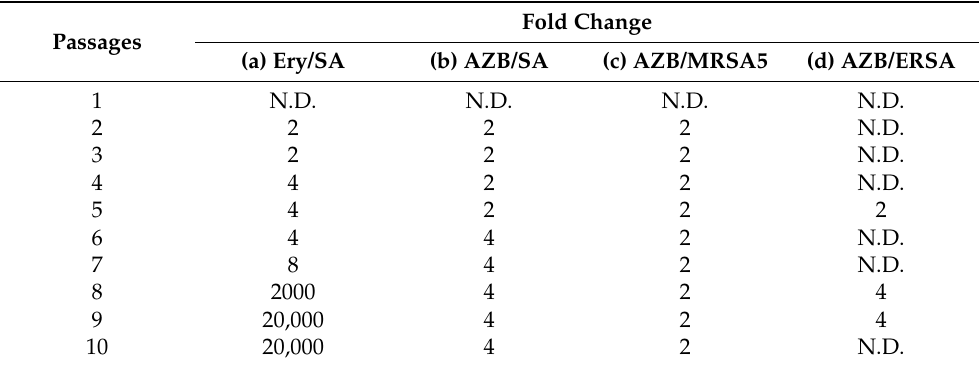
2000 20,000 20,000